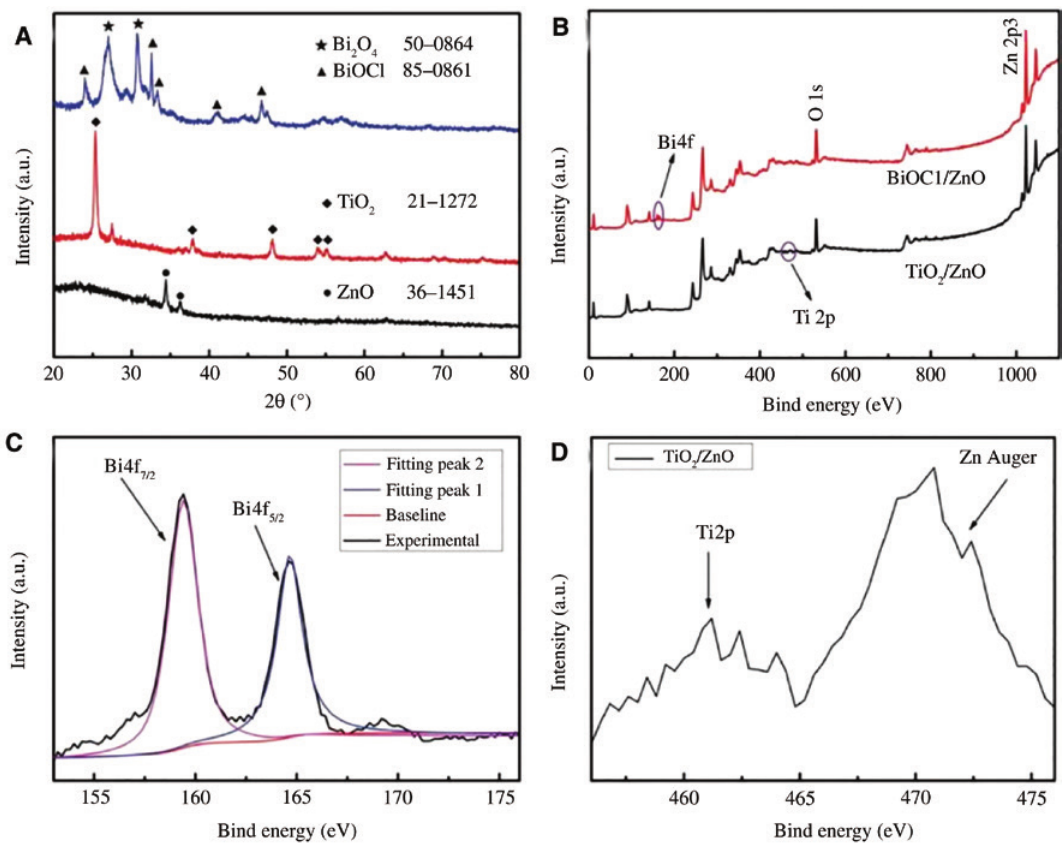
NPs (red line), and 2